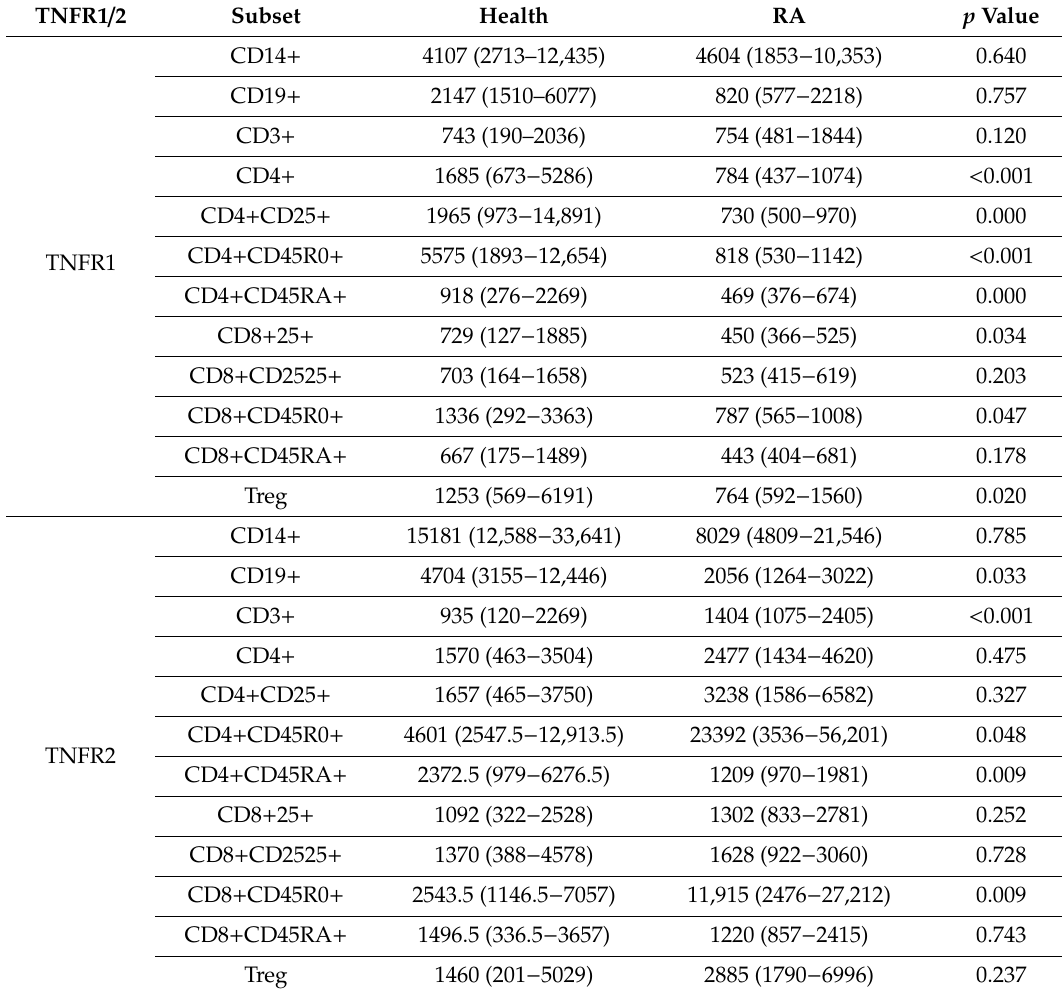
Table 1. Number of type 1 and 2 receptors for TNF α on the surfaces of immune cells. Data are presented as median and interquartile